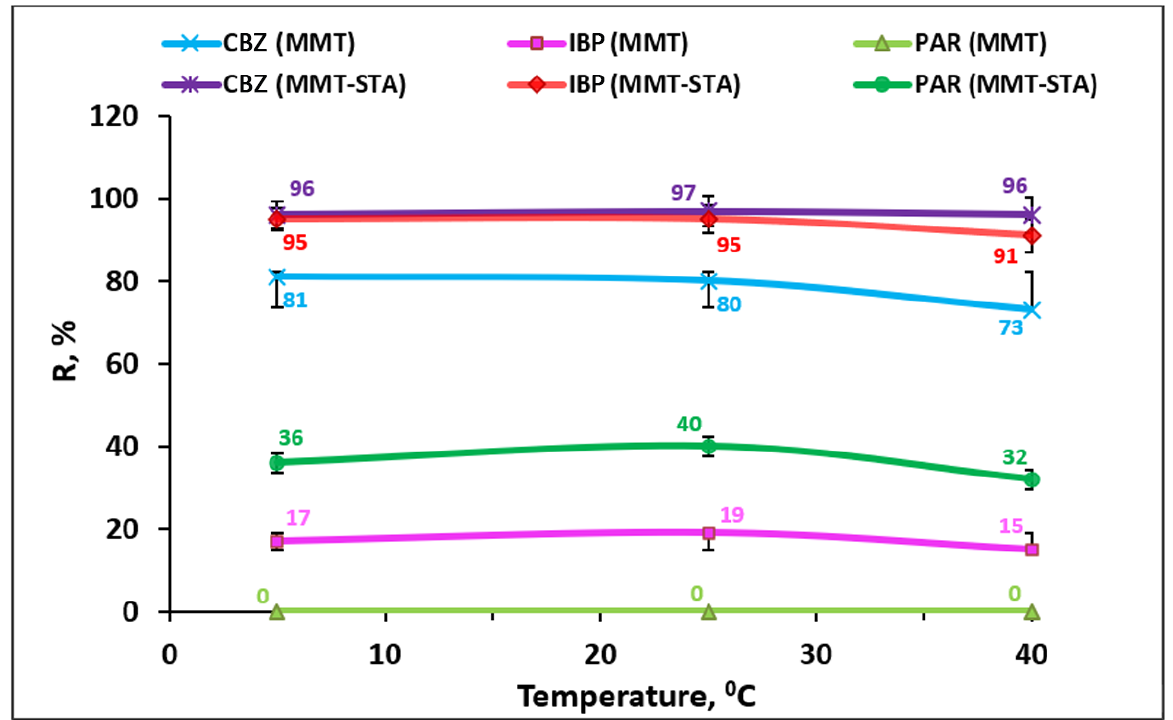
Figure 7. Effect of temperature on the removal efficiency of PP by MMT and modified MMT – STA.